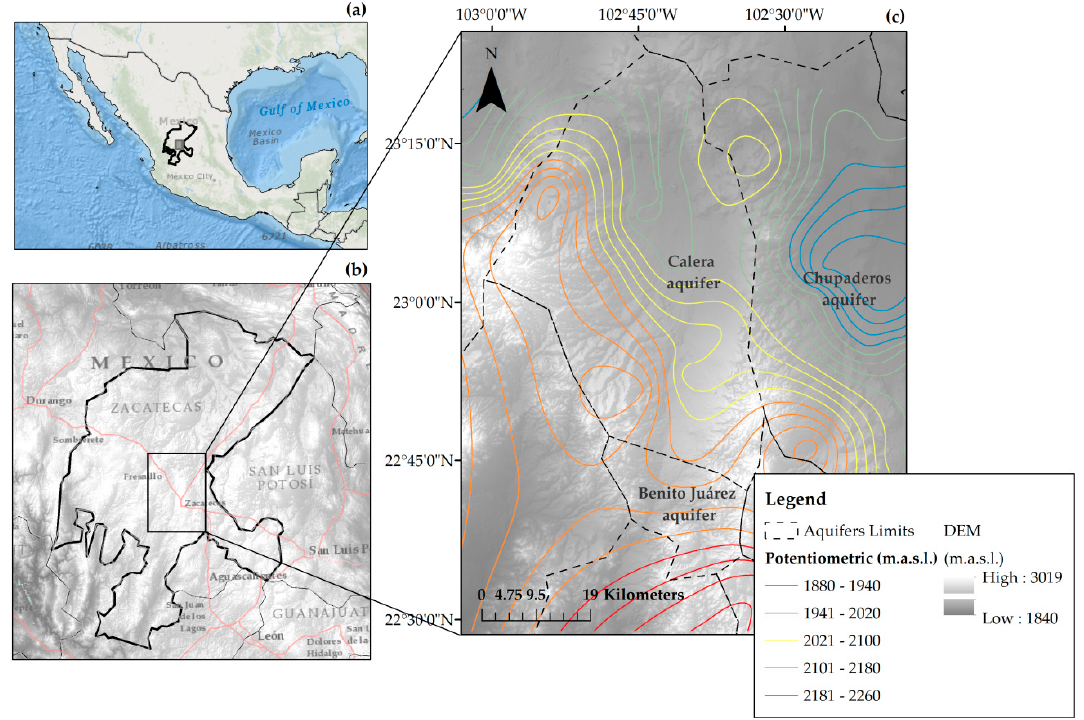
Figure 1. Study area showing the location of Mexico ( a ) with the Mexican State of Zacatecas ( b ), and a digital elevation model (DEM) showing the extent of Calera, Benito Juarez, and Chupaderos Aquifers ( c ).